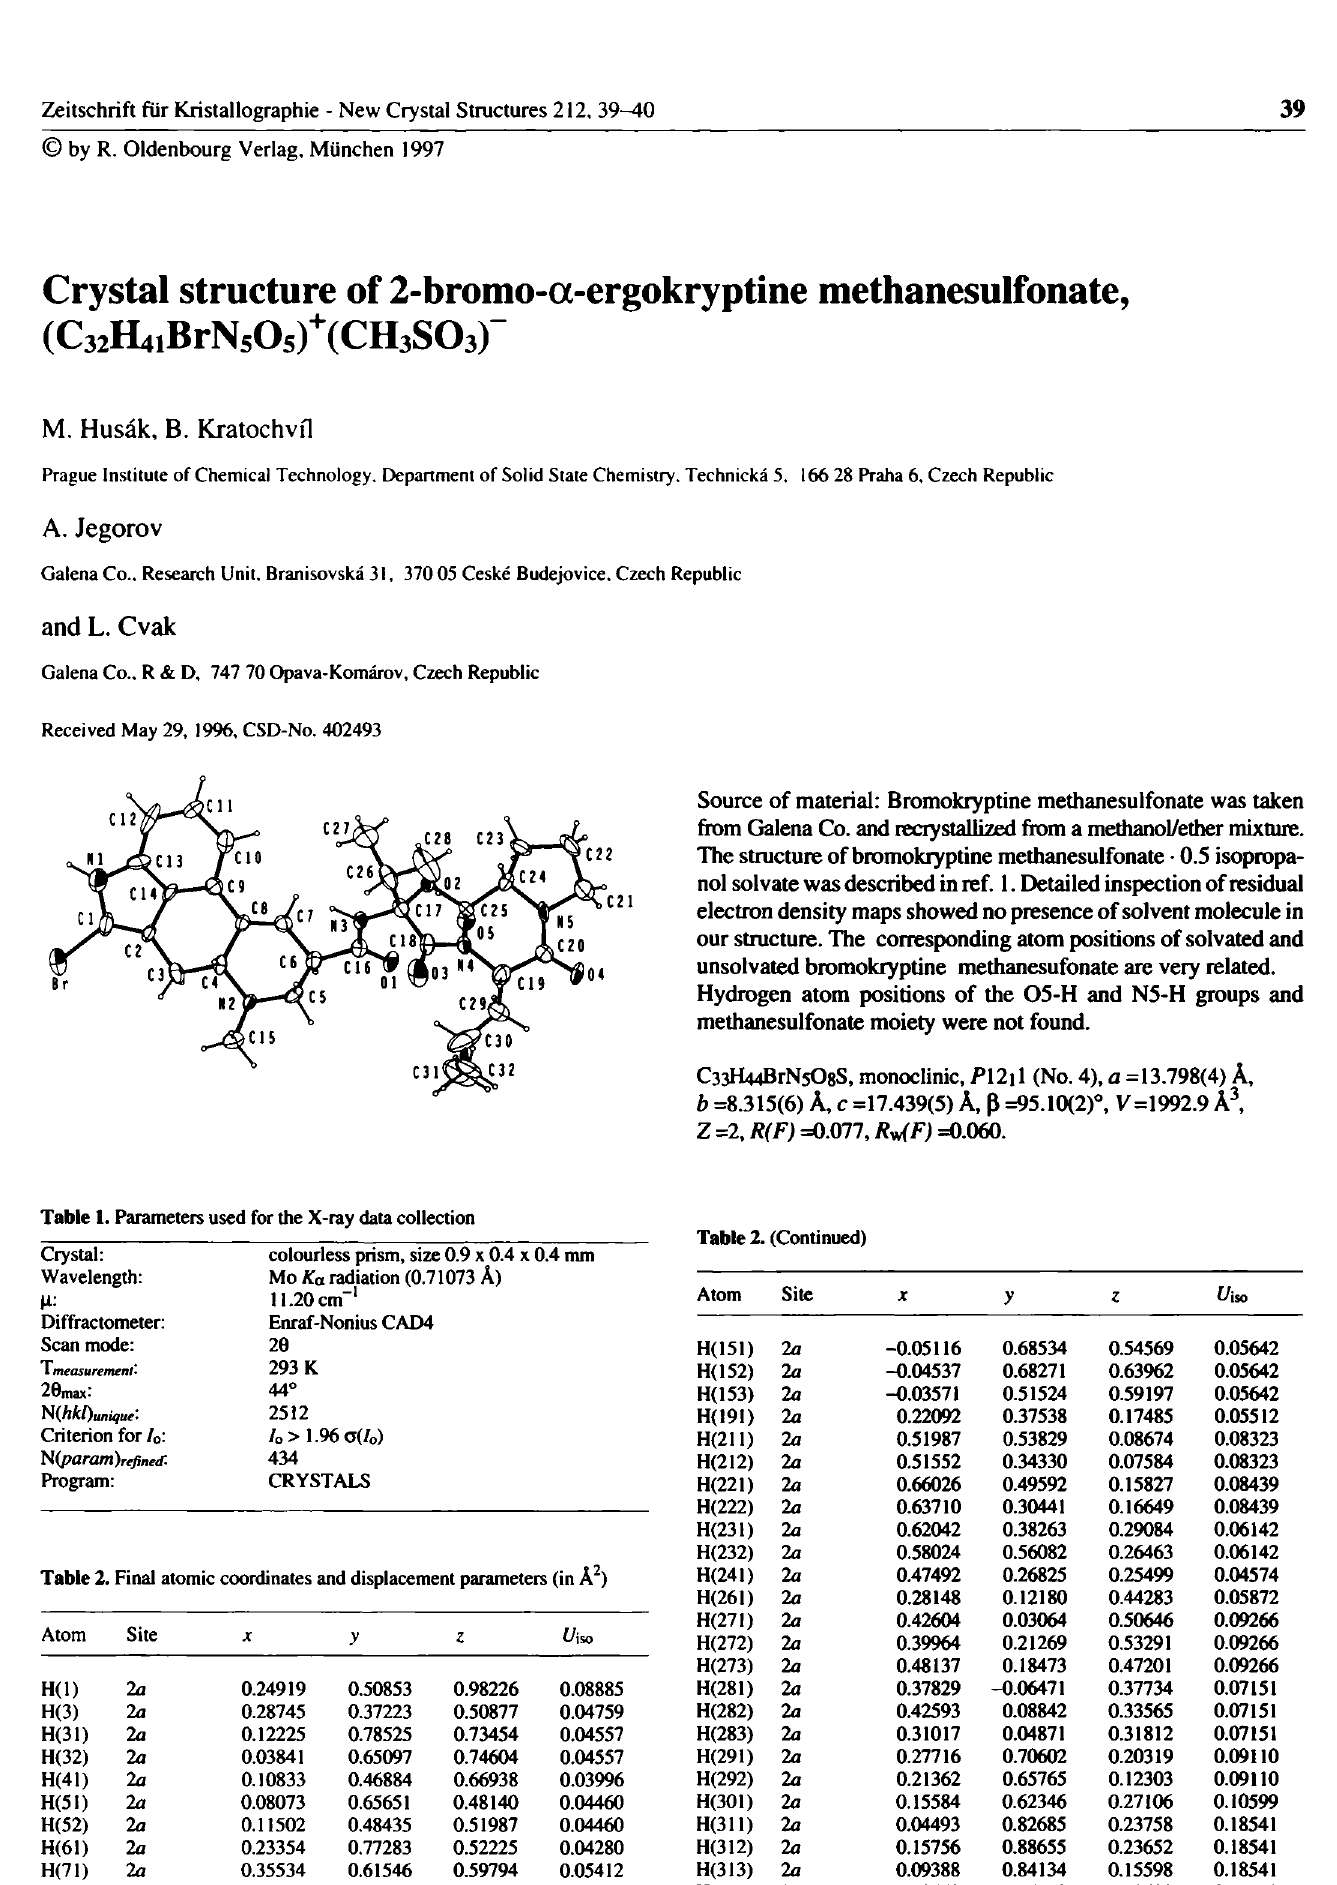
Table 2. Final atomic coordinates and displacement parameters (in Â 2 ) Atom